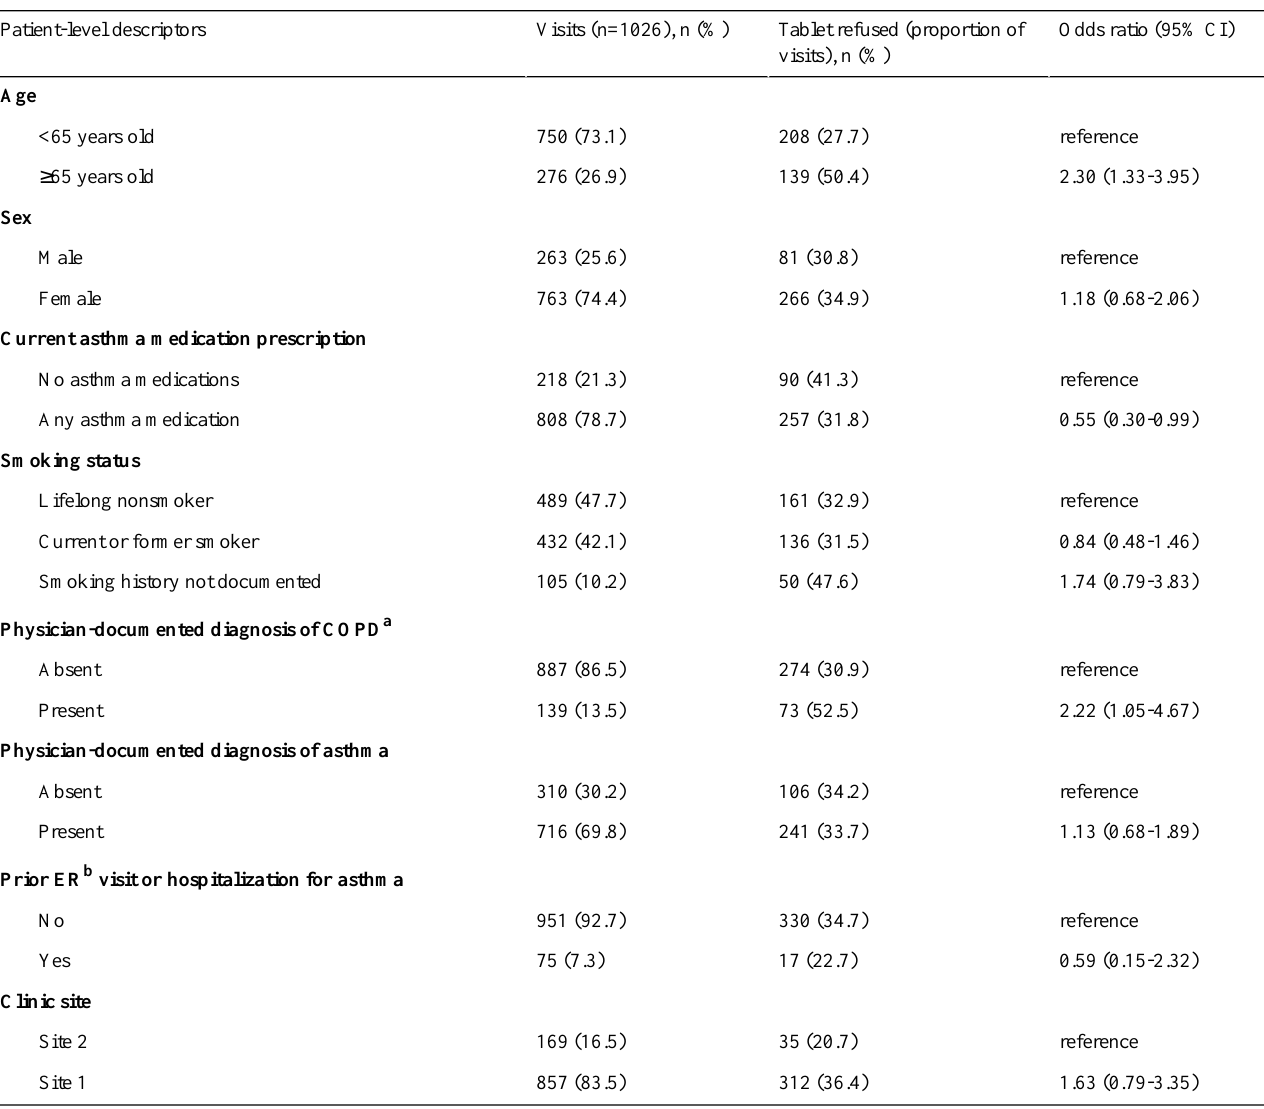
Table 3. Predictors of tablet refusal.